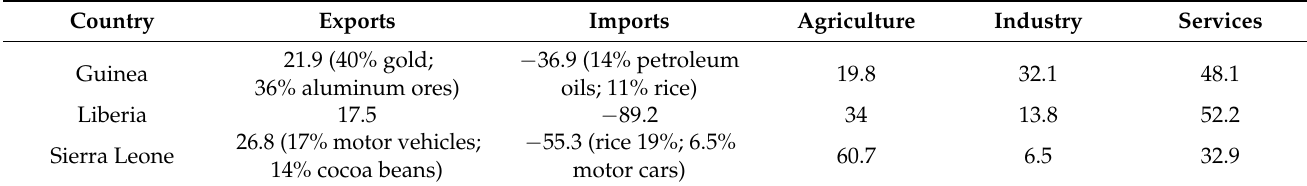
Table 1. Economic structure: selected indicators (in percentage of GDP).